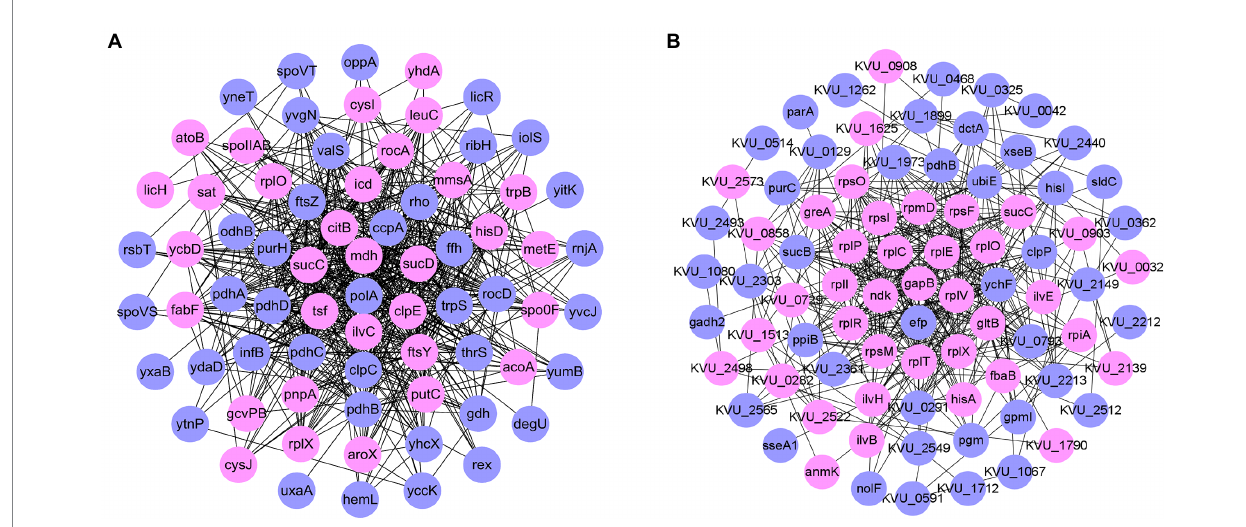
FIGURE 4 Network analysis of proteins based on differentially expressed proteins (DEPs) in B. pumilus (B18 vs. B40) (A) and K. vulgare (K18 vs. K40) (B) . Network analysis revealing the protein–protein interactions among upregulated proteins (pink circle) and downregulated proteins (blue circle).